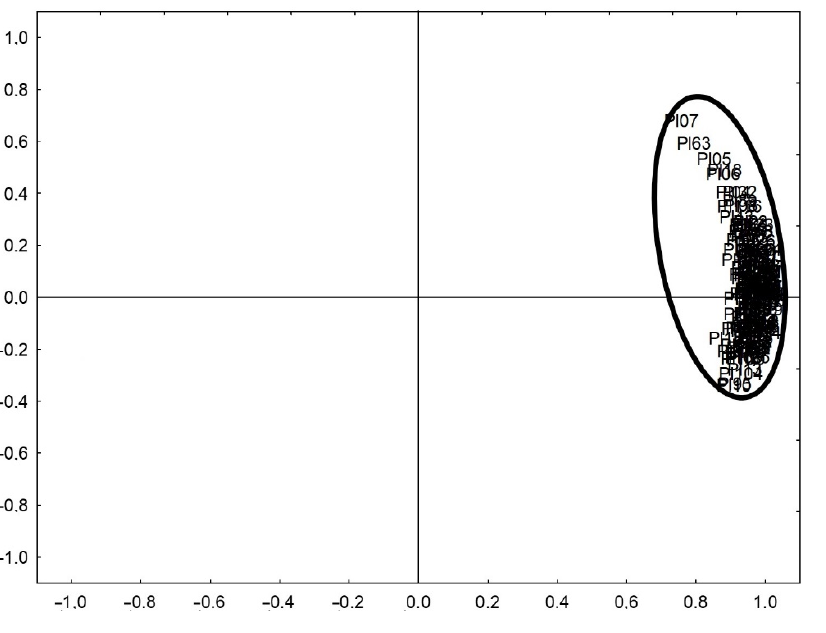
Figure 4. Results of Principal Components Analysis for elements concentration in pottery samples from Pl archaeological site.